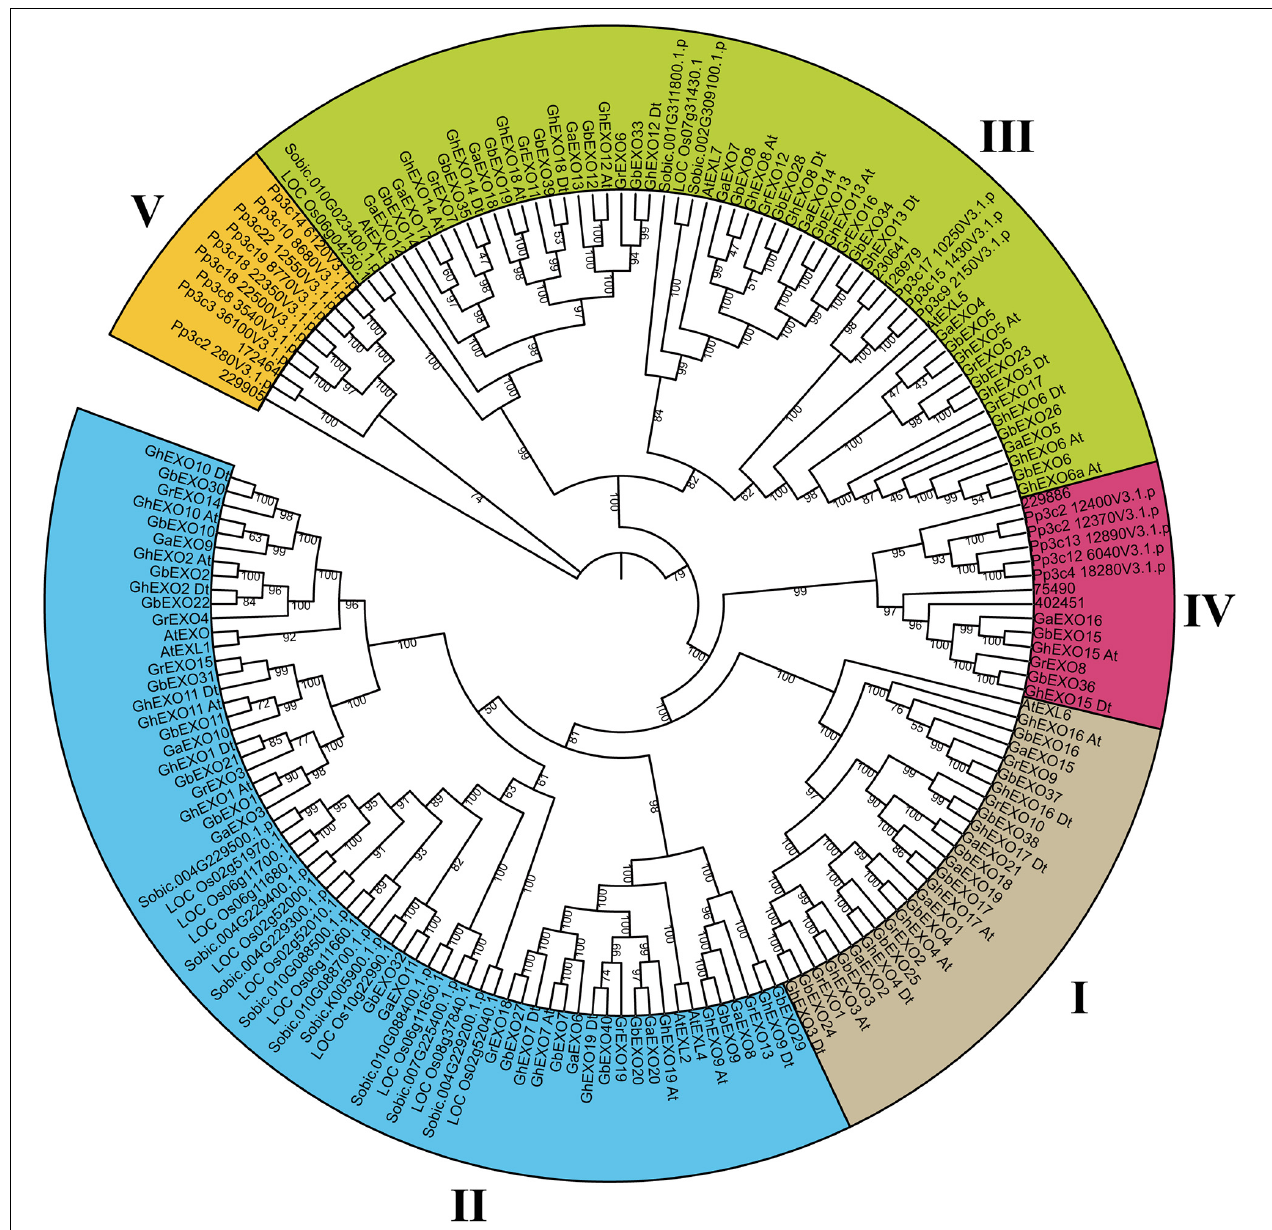
FIGURE 1 | Phylogenetic analysis of predicted proteins encoded by the EXO genes from nine plant species. Phylogenetic analysis grouped all 175 EXO proteins into five clades in a tree calculated using the ML (maximum likelihood) method. Clades I–IV are shown in different colors. The prefixes At, Ga, Gh, Gr, Os, Zm, Sobic, Sm, and Pp are used to identify EXO family proteins from A. thaliana , G. arboreum , G. hirsutum , G. raimondii , O. sativa , Z. mays , S. bicolor , S. moellendorffii , and P. patens , respectively. In addition, At and Dt refer to the A and D sub-genomes of upland cotton ( G. hirsutum ),